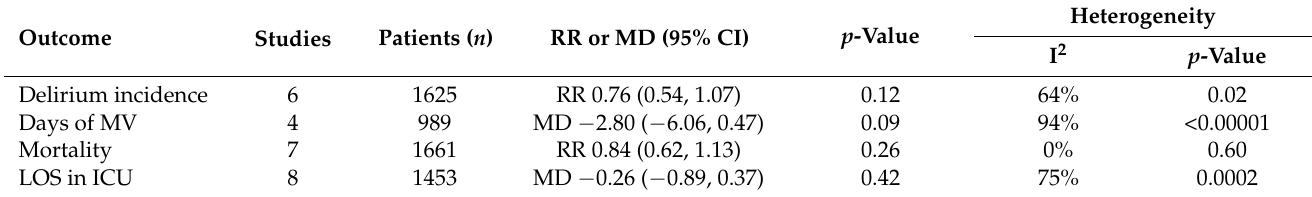
Table 2. Summary of the results of the primary and secondary outcomes comparing treatment with melatonin/ramelteon vs. placebo (control